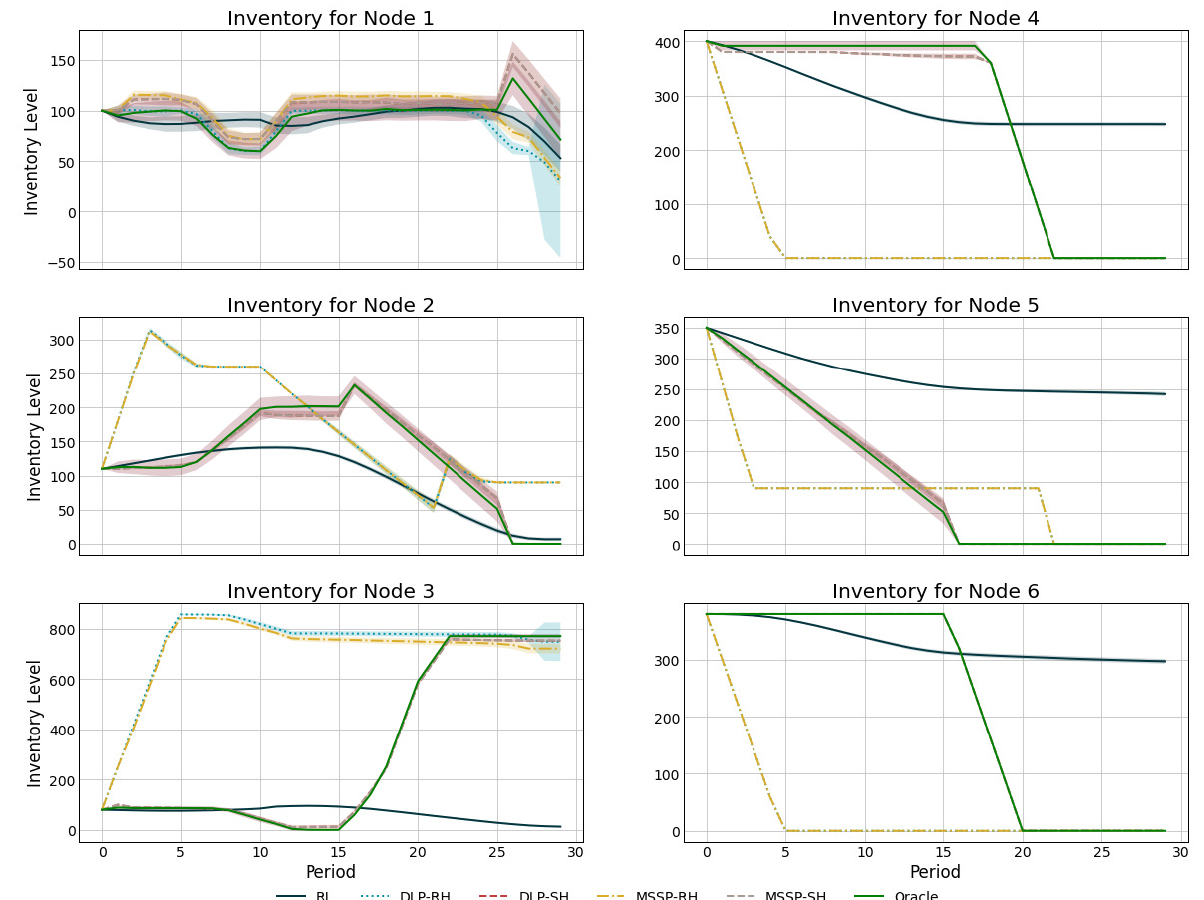
Figure 6. Average total inventory at each main network node (lost sales mode). Shaded areas denote ± 1 standard deviation of the mean value.